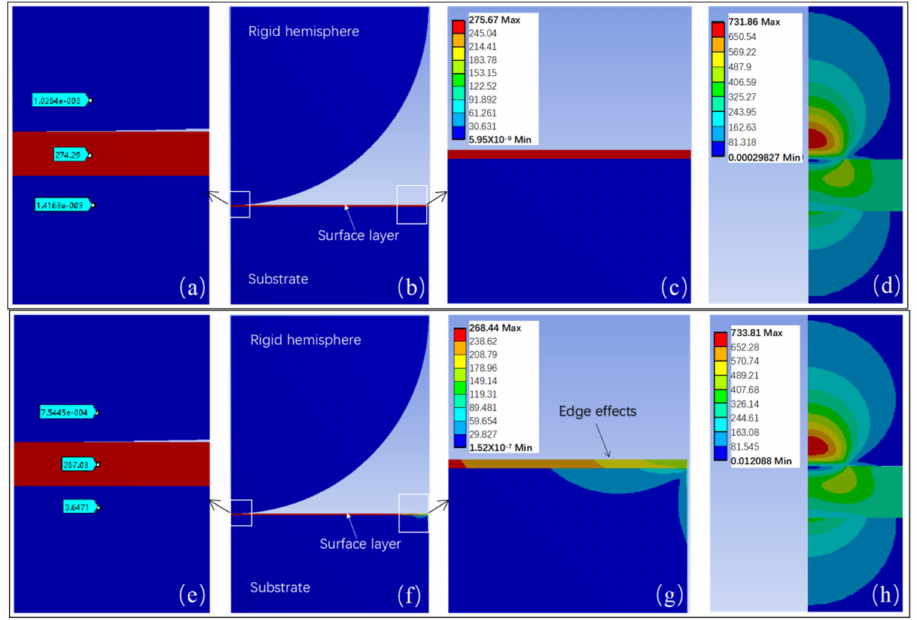
Figure A3. Examples of stress field for cases with different boundary conditions. The parameters are E s = 200 GPa, E l = 400 GPa, Y s = 600 MPa, Y l = 952 MPa, t/R = 0.006, and P = 0.05 N. ( a – d ) Roller boundary condition. ( e – h ) The outer surface is